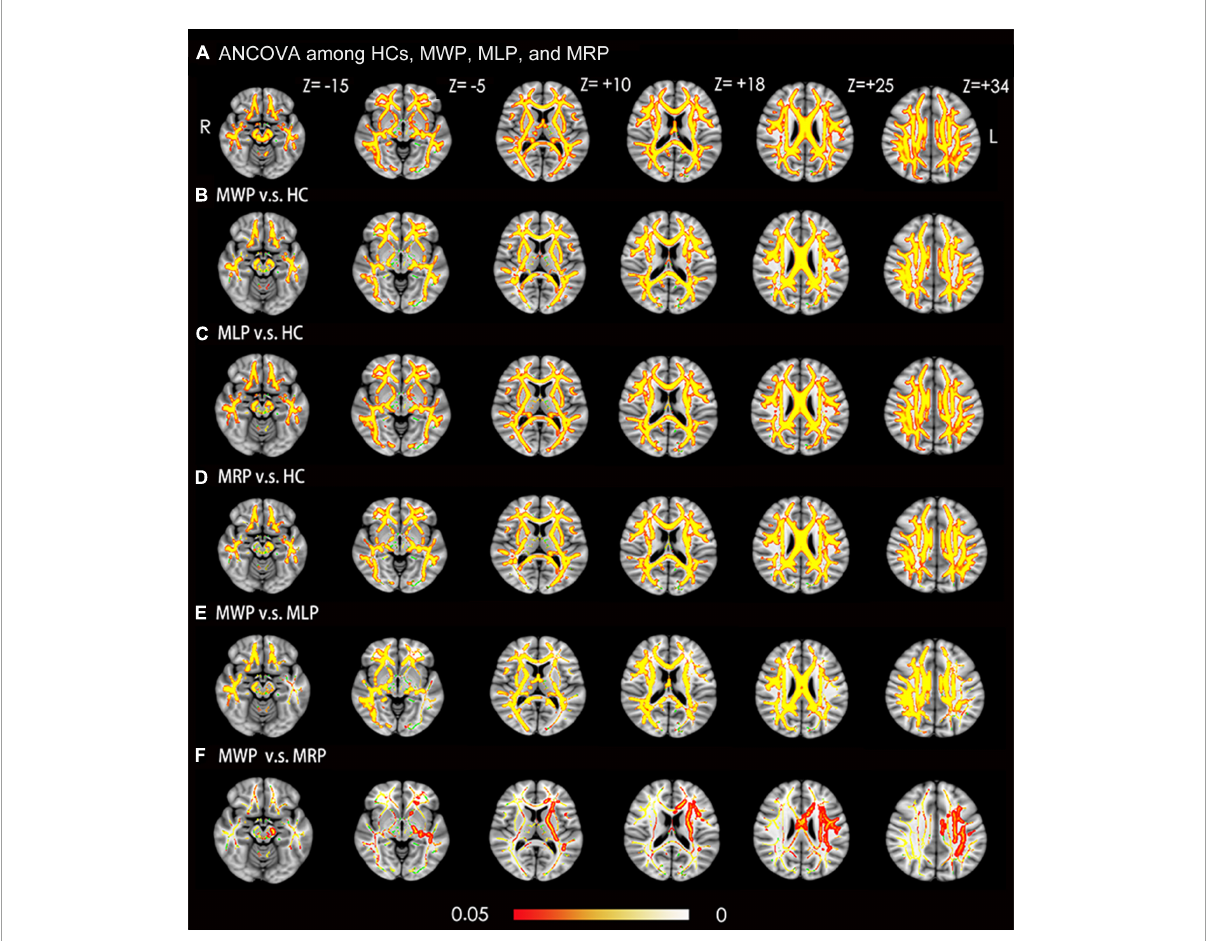
FIGURE2 Voxel-wise TBSS analysis results of fractional anisotropy (FA) images across MMD patients with or without limb paresthesia and healthy controls (HCs). (A) Significant differences in FA (red-yellow) between patients without paresthesia (MWP), patients with left-limb paresthesia (MLP), patients with right-limb paresthesia (MRP), and HCs ( p < 0.05; FWE corrected based on the threshold-free cluster enhancement statistical image). Post hoc analyses revealed significant reductions in FA (red-yellow) in the MWP (B) , MLP (C) , and MRP (D) groups in comparison with HCs. Post hoc analyses also revealed significant reductions in FA (red-yellow) in the MLP (E) and MRP (F) groups in comparison with the MWP group. Green represents the mean white matter skeleton of all participants. The color scale (red-yellow) represents significant differences between groups, with colored regions exceeding the significance threshold of P < 0.05. The left side of the image corresponds to the right hemisphere of the brain. ANCOVA, analysis of